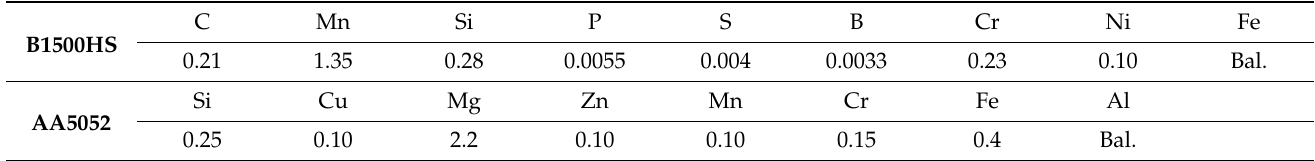
Table 1. Chemical compositions of B1500HS and AA5052 sheets (wt.%).